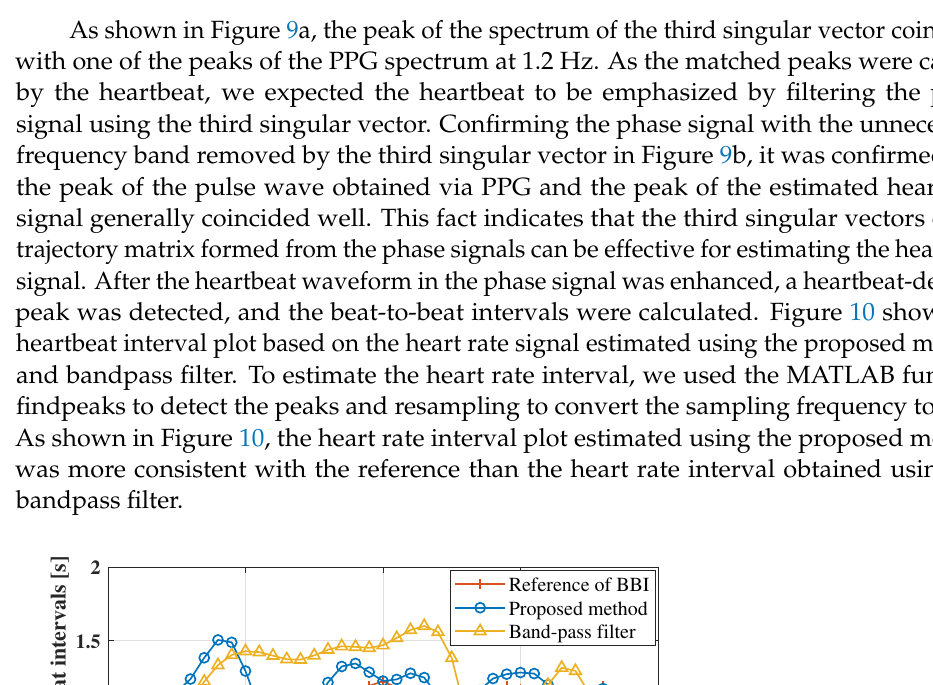
Figure 9. Examples of the heart rate enhancement effect by the proposed technique: ( a ) shows the comparison of the frequency response of the PPG signal, the 3rd singular vector used for heart rate emphasis, and the IIR-type bandpass filter; ( b ) shows the time-domain waveforms of the PPG signal and the heart rate signal estimated by the proposal method.